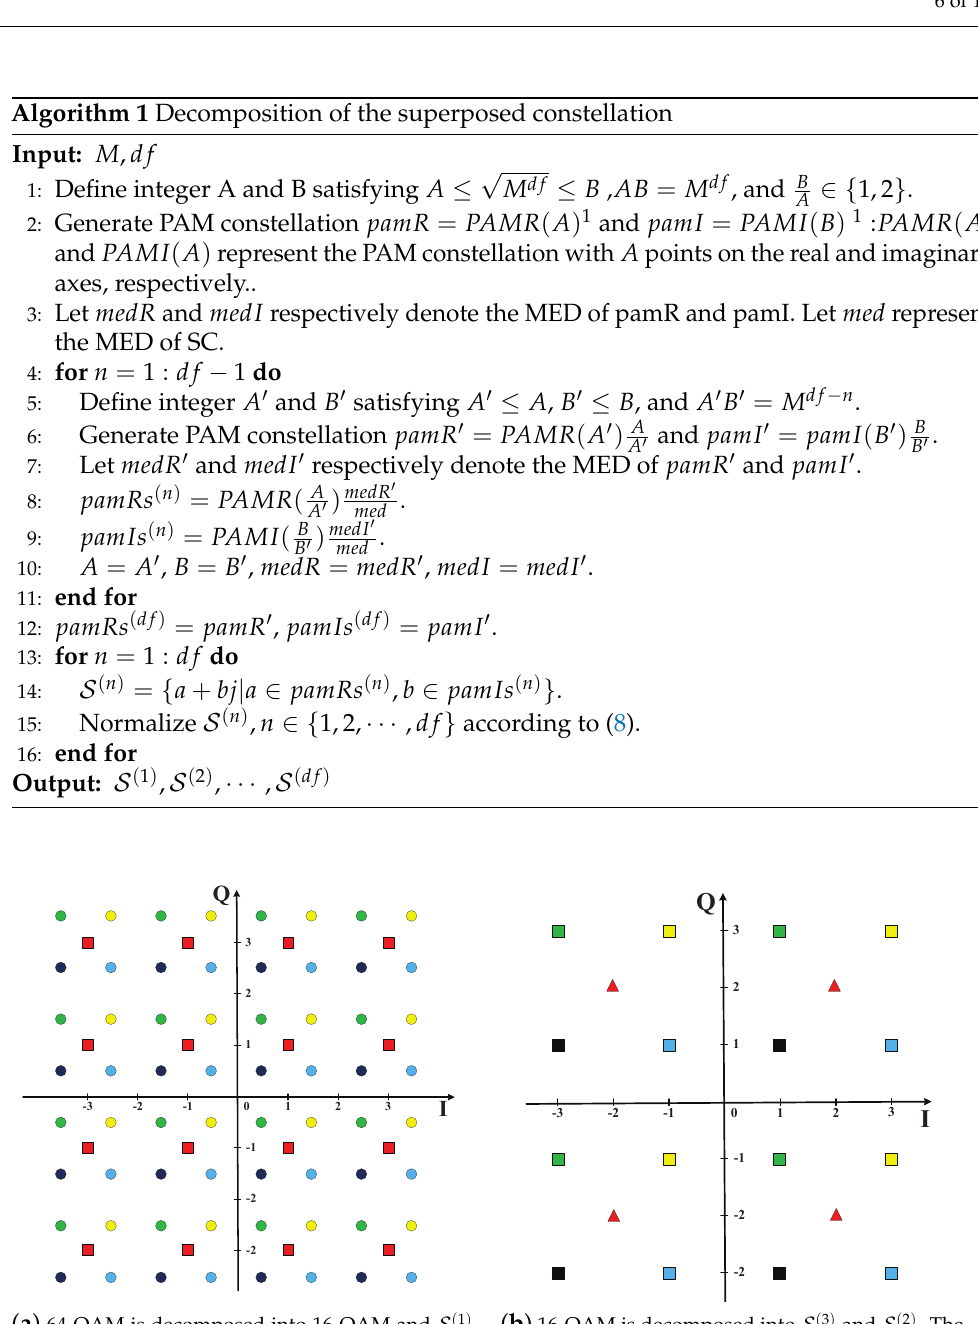
Figure 3. 64-QAM is decomposed into three